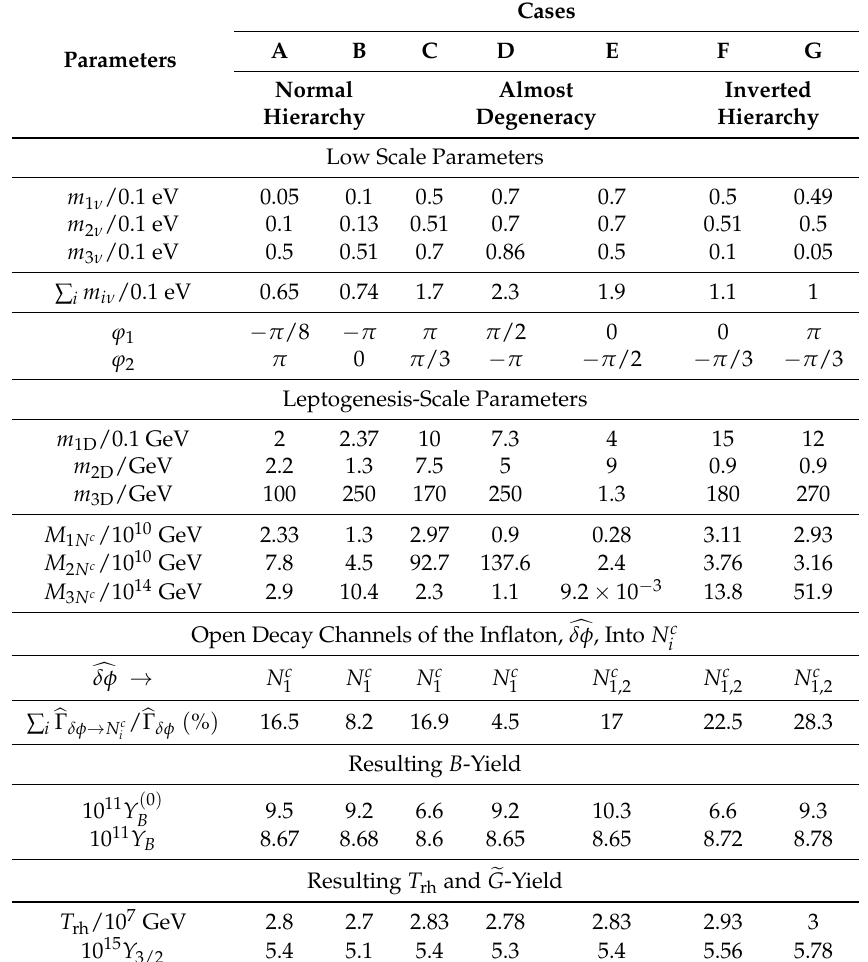
Table 6. Parameters yielding the correct Y B for various neutrino mass schemes. We take K = K 2 or K 3 ) in Equation (39b), λ µ = 10 − 6 and y = 0.5. with N X = 2, ( n , r ±